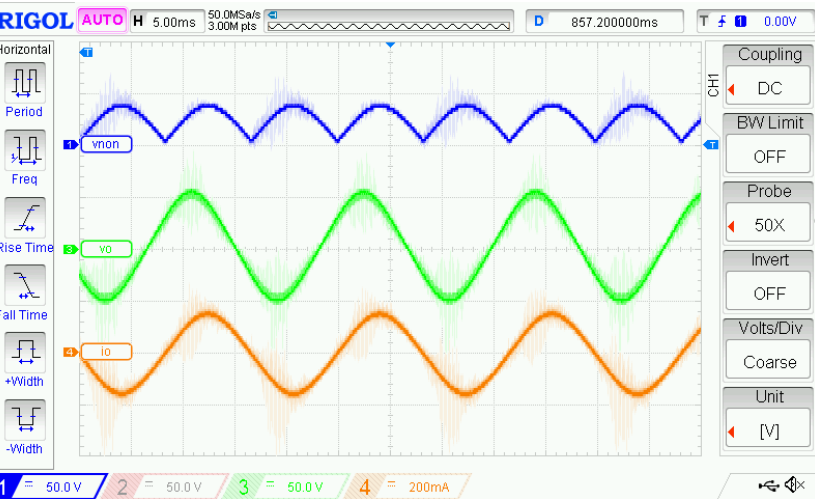
Figure 28. Measurement of output voltage, output current, and the voltage across the full wave rectifier diode bridge circuit.